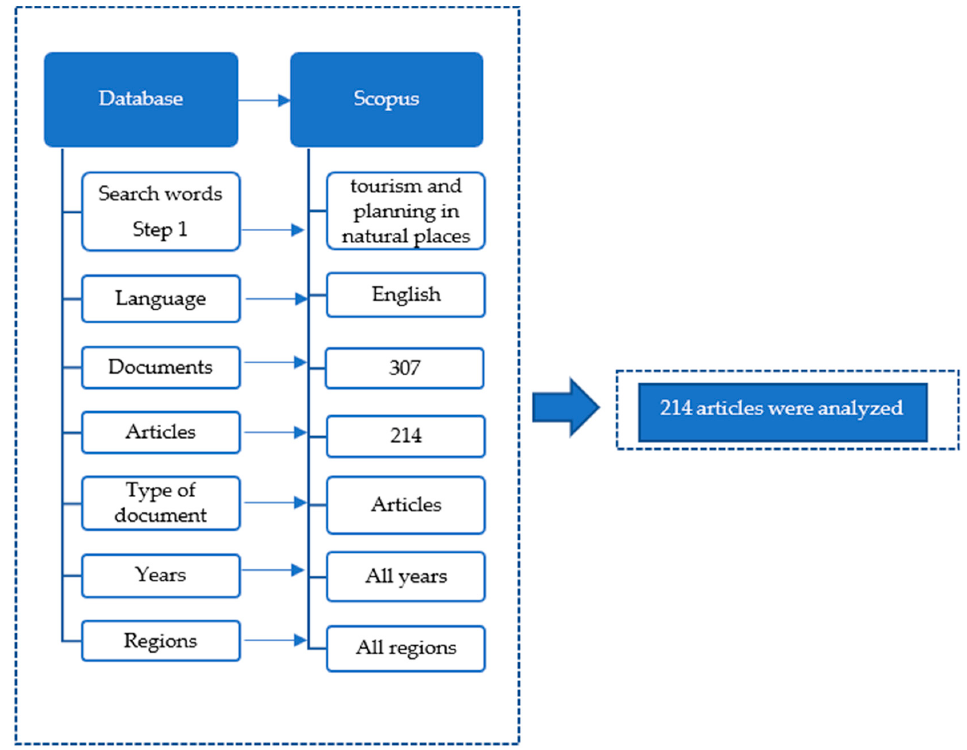
Figure 1. Data collection procedures.